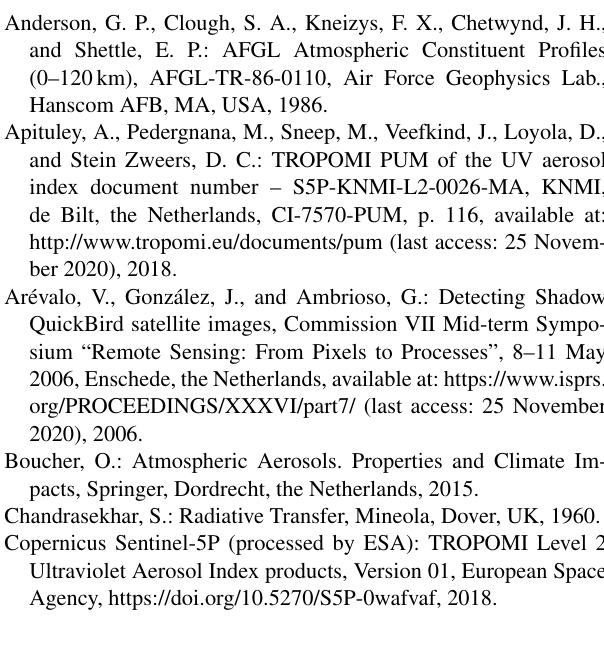
Australian smoke plumes can be detected by TROPOMI with unprecedented sensitivity to small details at high spatial res-